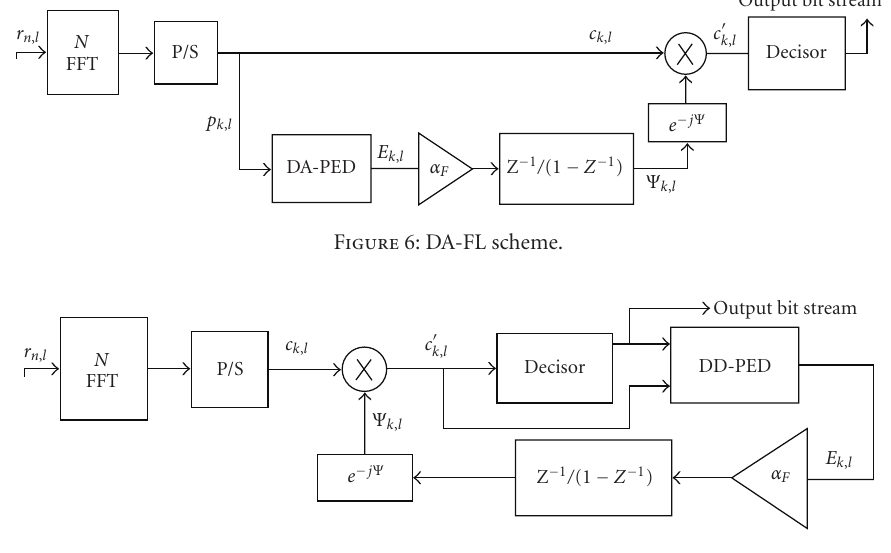
Figure 7: DD-FL scheme.